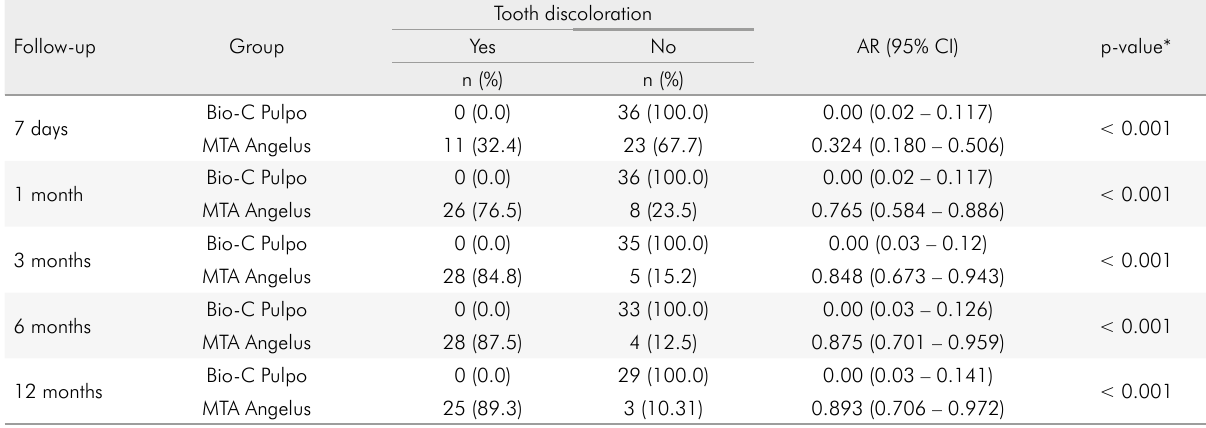
Table 4. Absolute and relative frequency of tooth discoloration after pulpotomy in Bio-C Pulpo and MTA Angelus groups, at the seven-day, and one-, three-, six- and 12-month